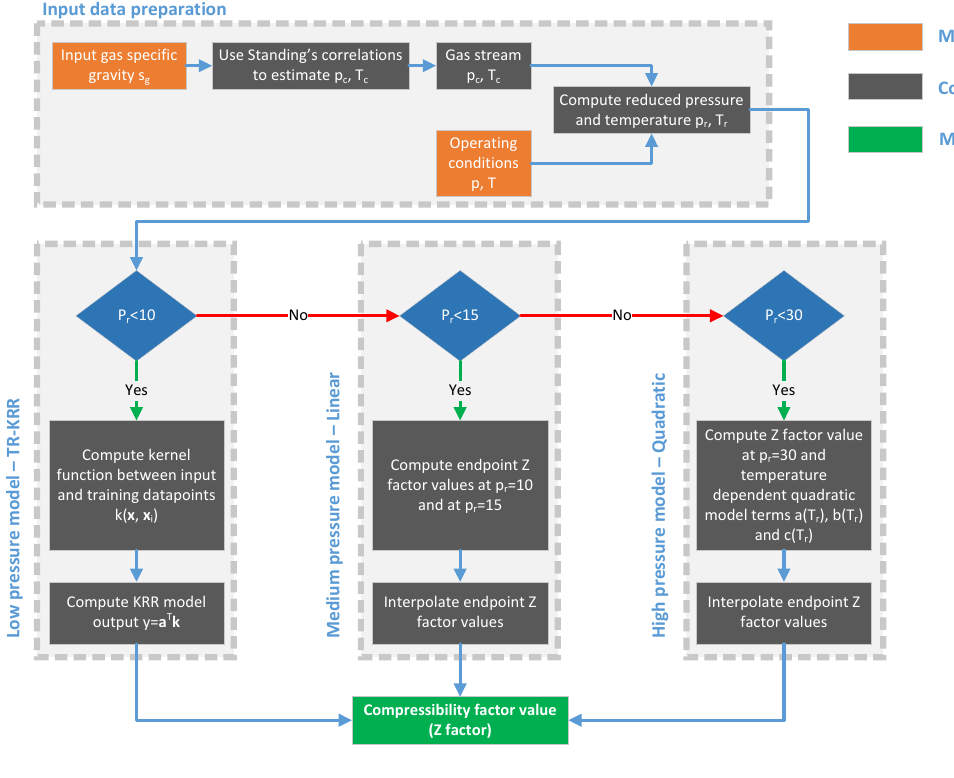
Figure 2. General sketch of the proposed